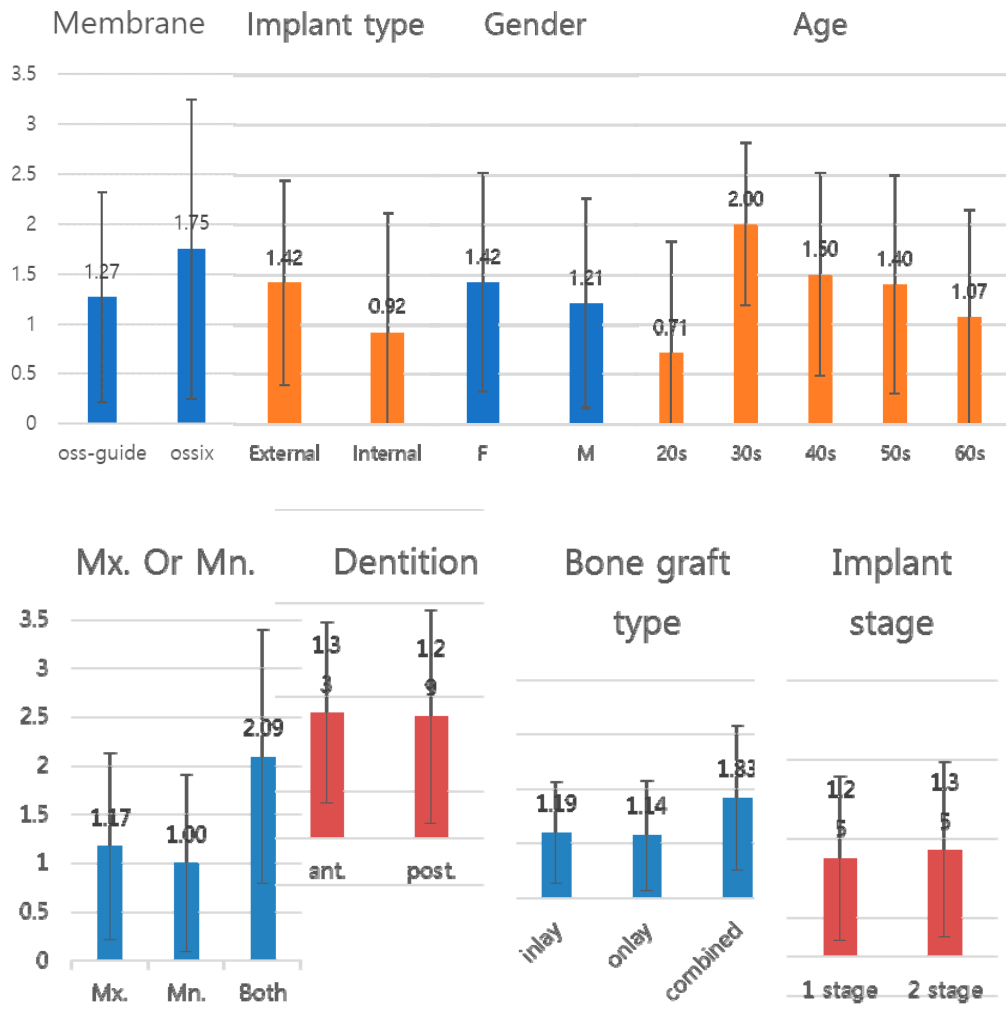
Figure 3. Graph of Table 1. The y-axis represents the number of implant threads exposed. The values of the y-axis are constant, and the numerical values of each factor can be easily compared. As a result of comparing with constant y-axis values, it can be seen that the number of implant thread exposures caused by various factors is not significantly different. Factors that cause a noticeable number of thread exposures are not observed.